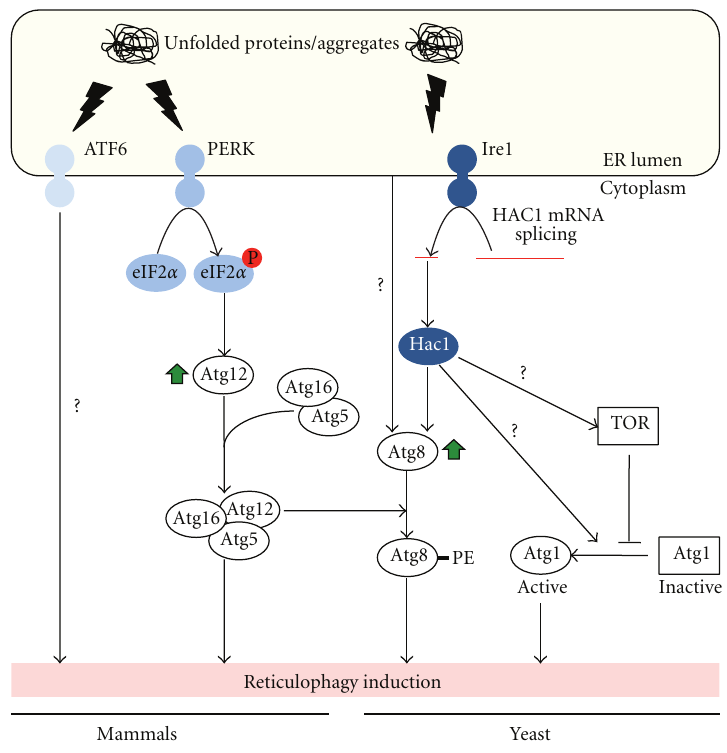
Figure 2: Signalling cascades inducing reticulophagy upon ER stress. The transmembrane protein Ire1 (yeast and mammals), ATF6, and PERK (mammals) sense the accumulation of unfolded proteins and/or aggregates, and trigger a general transcriptional response that a ff ect the levels of proteins involved in autophagy. These include Atg8 (signal mediated through Ire1/Hac1 and unidentified alternative pathways in yeast) and Atg12 (mediated by the PERK/eIF2 α signalling cascade in mammals). The Atg12-Atg5 (Atg16) complex facilitates the lipidation of Atg8 and autophagy induction. Unknown signalling events in yeast, dependent or independent of the inhibition of the Tor kinase, promote Atg1 activation. Green arrows indicate an increase in protein levels. Question marks indicate signalling cascades that may exist but have not yet been